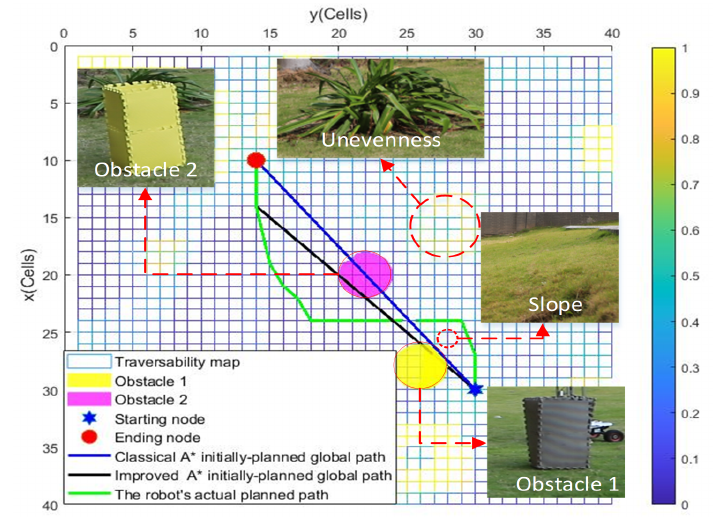
Figure 9. The planned paths in Exp